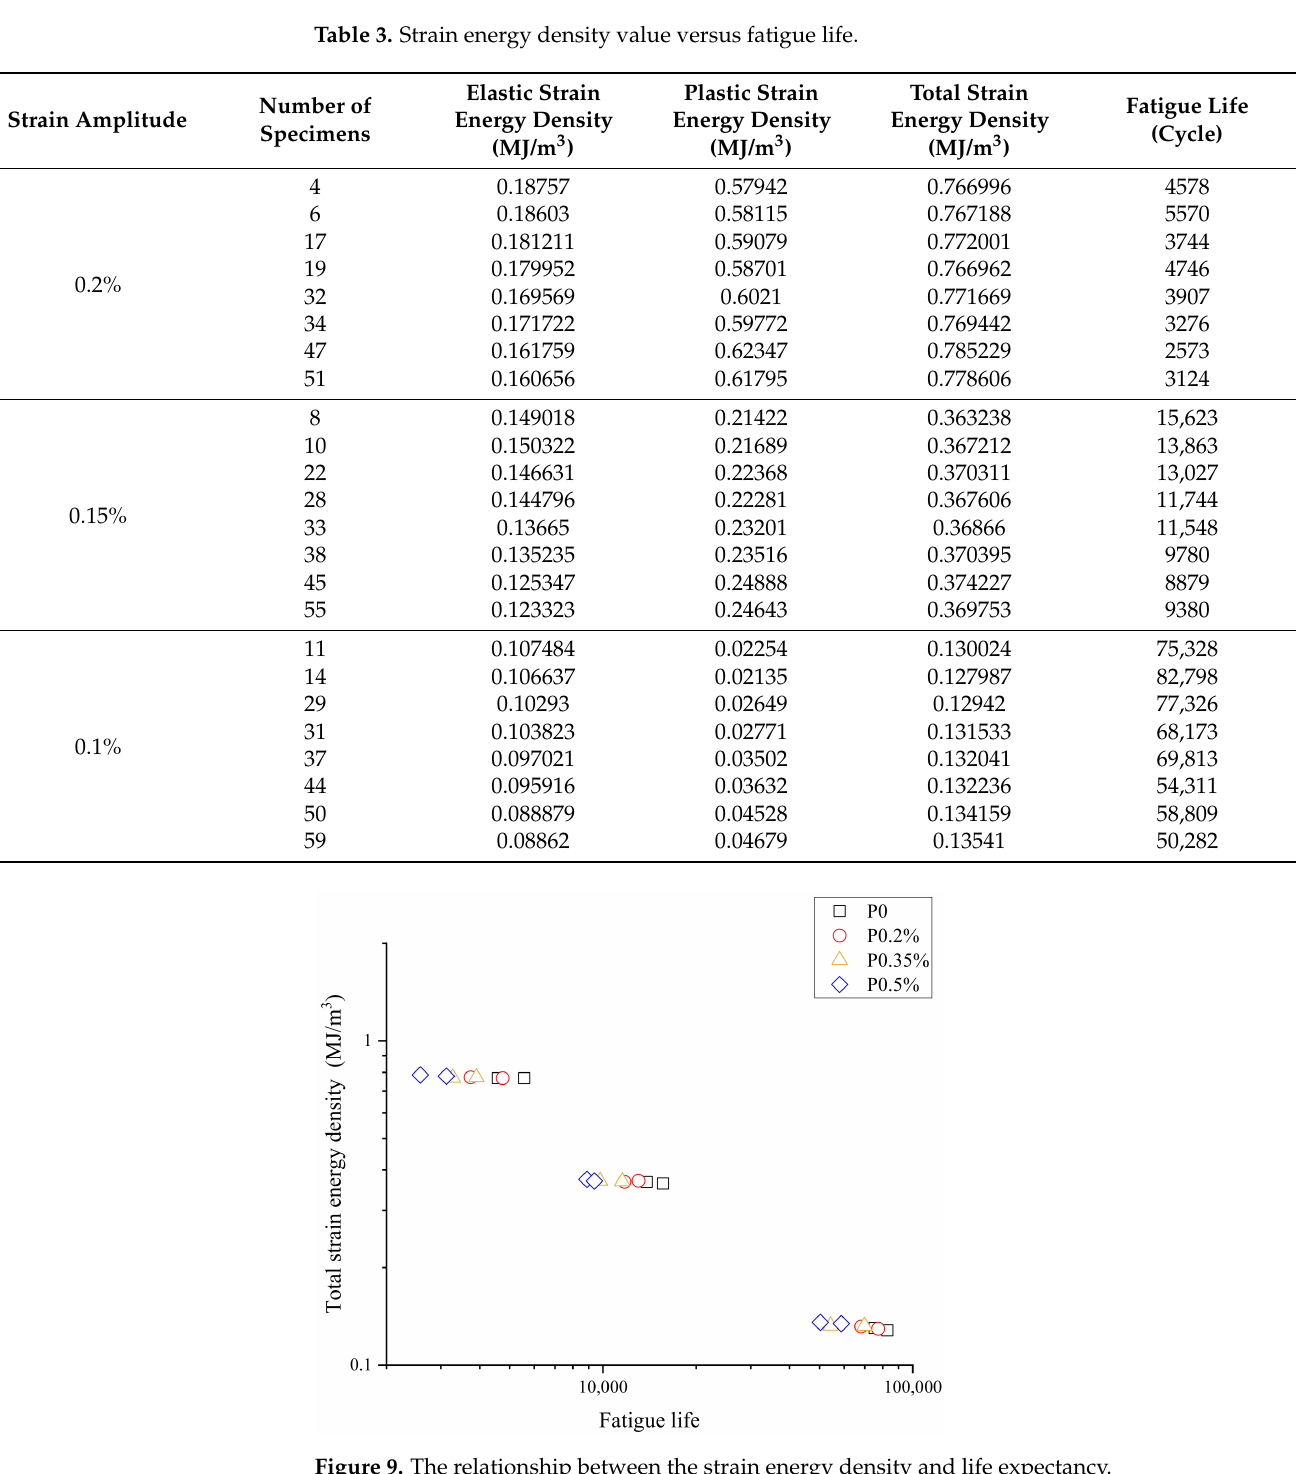
Figure 9. The relationship between the strain energy density and life